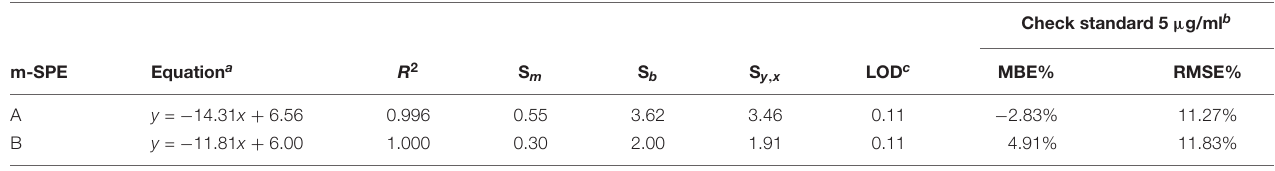
TABLE 3 | Calibration curve equations and uncertainty in the regression analysis for the histamine determination in enriched broth cultures of the two m-SPE (A and B) used for the recovery tests.